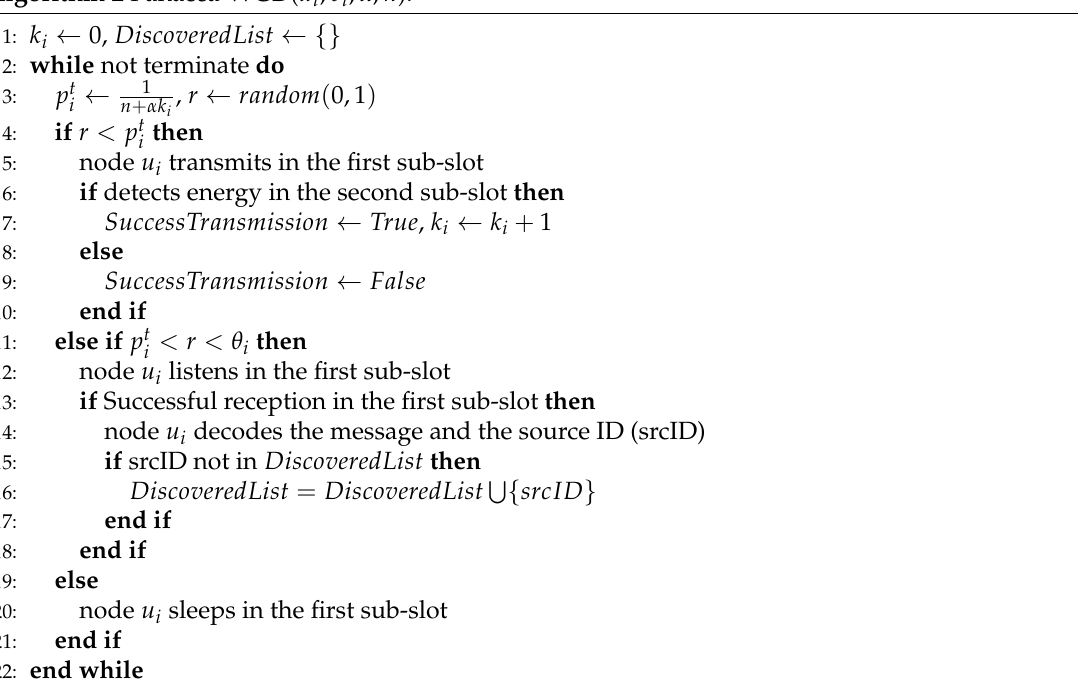
Algorithm 2 Panacea-WCD( u i , θ i , α , n